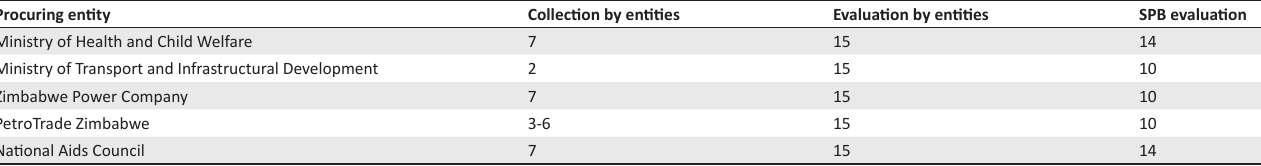
TABLE 8: Days taken to collect tender documents and evaluation periods. Procuring